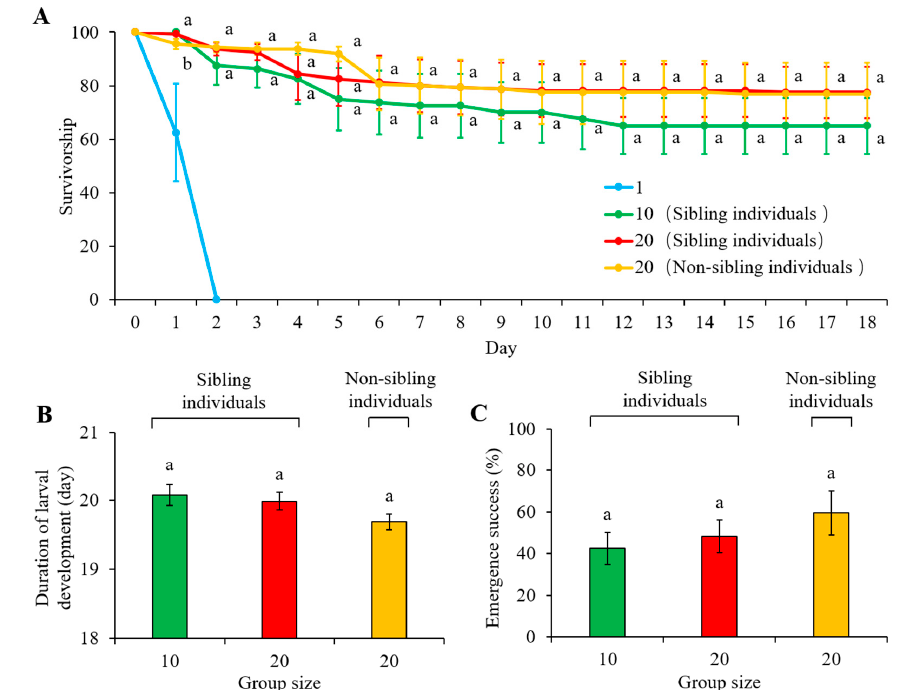
Figure 6. ( A ) Larval survivorship, ( B ) duration of larval stage, and ( C ) emergence success of adults of Heortia vitessoides individuals in the treatments containing: (1) single larva originated from each sibling cohort; (2) 10 larvae originated from the same sibling cohort; (3) 20 larvae originated from the same sibling cohort; and (4) 10 larvae originated from one sibling cohort and 10 from another. Since all newly hatched larvae died within two days after they were isolated, the comparisons were conducted for the latter three treatments. Data were presented as mean ± SE, and different letters indicate significant differences ( p < 0.05). Table 3. The developmental stages (I: first instar; II: second instar; III: third instar; IV: fourth instar; V: fifth instar; P: pupae) of Heortia vitessoides individuals during the whole larval stage after the newly hatched larvae were initially assigned into 20-larvae cohorts (containing sibling individuals). Note that the larvae of different developmental stages (instars) can be observed within the same sibling cohort at the same period.